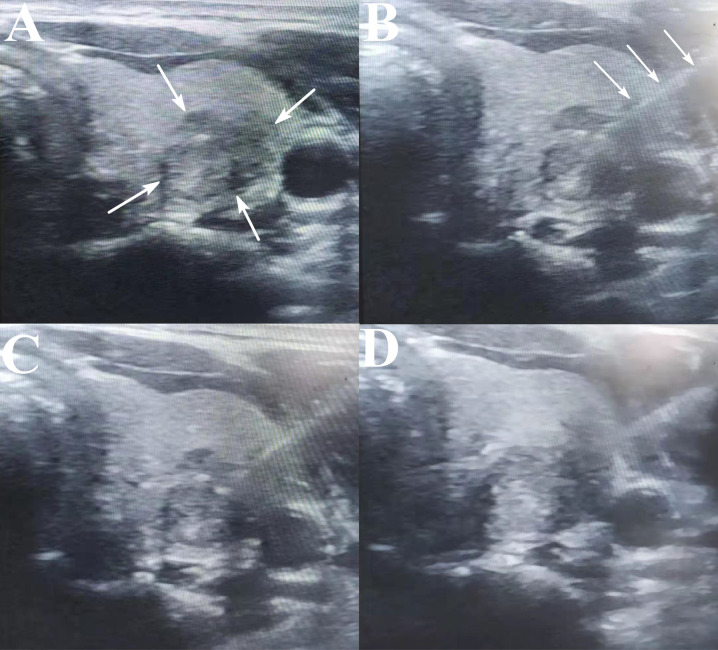
The images of a 46 year-old female undergoing MWA. (A) The BTN before ablation: the arrows indicate BTN. (B, C). During the ablation procedure: the arrows indicate the ablation electrode. (D) The BTN after ablation procedure.